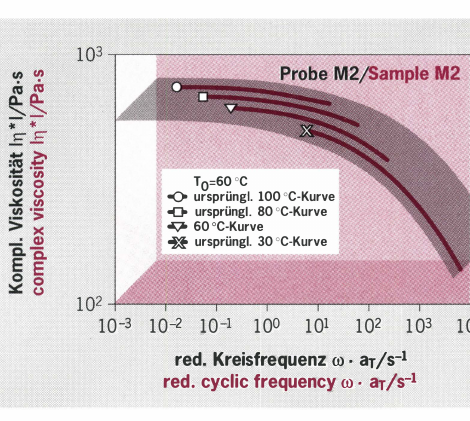
red. Kreisfrequenz ro a1js-1 . red. cyclic frequency ro . a1;s-1 ty. At low temperatures, this non-Newtonian